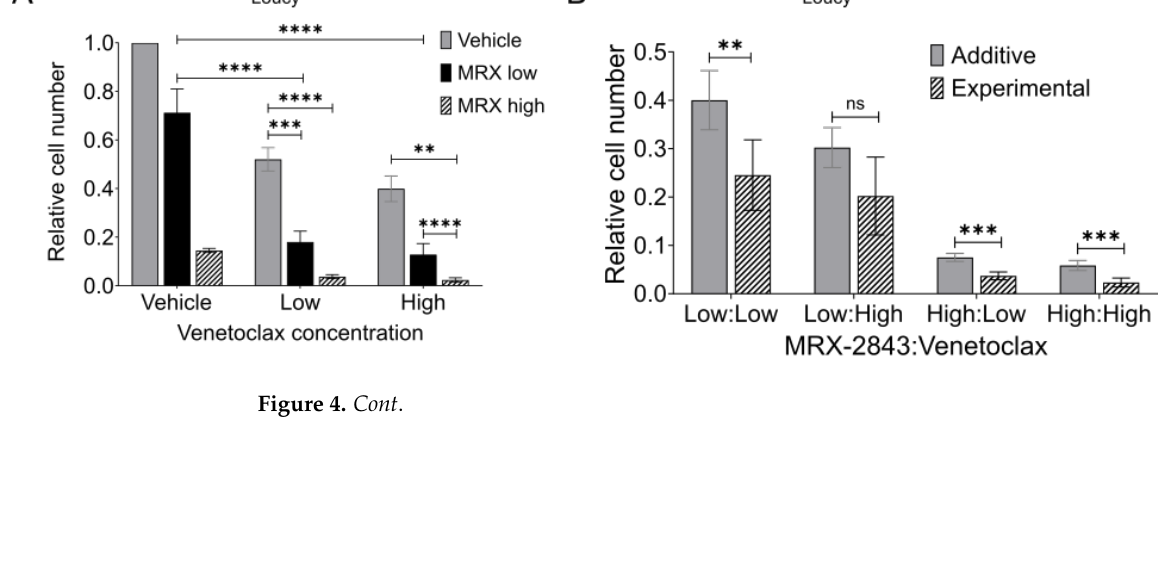
Figure 4. MRX-2843 and venetoclax mediate synergistic anti-leukemia activity in ETP-ALL cell lines. ( A , B ) Loucy cells were plated in triplicate at 20,000 cells/well and cultured for 24 h before treatment with vehicle, MRX-2843 (low = 62.5 nM, high = 125 nM), venetoclax (low = 250 nM, high = 500 nM), or MRX-2843 and venetoclax combined for an additional 48 h. After treatment, cells were stained with CellTiter-Glo reagent, luminescence was measured, and cell numbers were calculated relative to the DMSO control. Mean values ± SEM were derived from four independent experiments. For ( B ), expected additive values were calculated using the fractional product method and compared with experimentally observed values (** p ≤ 0.01, *** p ≤ 0.001, **** p ≤ 0.0001, unpaired t -test). ( C , D ) ETP-ALL cell lines (Loucy and PEER) were treated in quadruplicate with pairwise drug combinations of MRX-2843 and venetoclax, and relative cell numbers were determined utilizing a high-throughput platform and the CellTiter-Glo readout. ( C ) Relative growth inhibition was calculated by subtracting background luminescence and normalizing to vehicle controls. ( D ) Synergy was calculated using the Response Additivity model. Values >1% indicate synergistic, values <−1% are antagonistic, and all others are additive. Black boxes in ( C , D ) represent combinations of MRX-2843:venetoclax at a 1:20 dose ratio. Abbreviations: ns – not significant 3.6. MRX-2843 Reduces Disease Burden and Prolongs Survival in Orthotopic T-ALL and ETP- ALL Cell Line Xenograft Models In mice with xenografts of a luciferase expressing Jurkat T-ALL cell line [28], treatment with 75 mg/kg MRX-2843 significantly reduced disease burden, indicated by reduced bioluminescence (Figure 5A), and prolonged survival by 50% compared with vehicle-treated control mice (Figure 5B). Treatment with 65 mg/kg MRX-2843 also significantly reduced disease burden (Figure 5C) and extended median survival from 38 to 43 days in a luciferase-expressing xenograft model of the ETP-ALL cell line Loucy (Figure 5D). A repeat experiment in this model using the same dose of MRX-2843 yielded similar results (Figure S2); although, in this case, the prolongation in median survival seen in mice treated with MRX-2843 did not reach statistical significance.